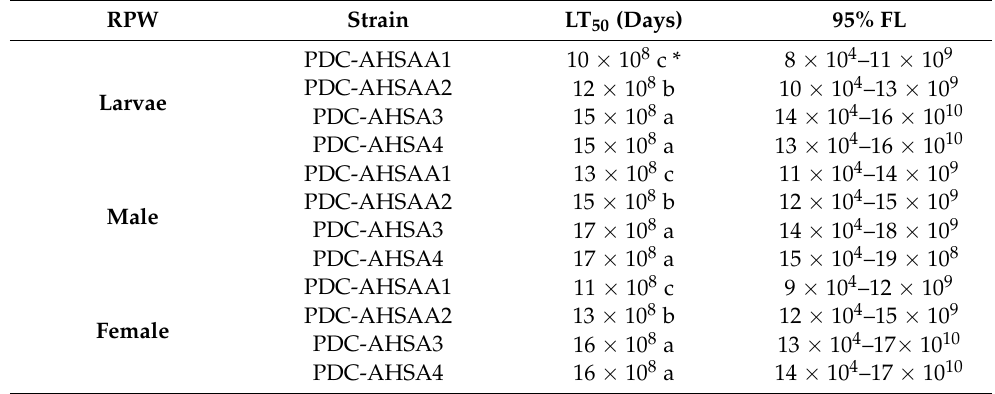
Table 2. The impact of Bacillus thuringiensis and B. cereus isolates against RPW larvae and adults (males and females) after 21 days of the bioassay being performed.